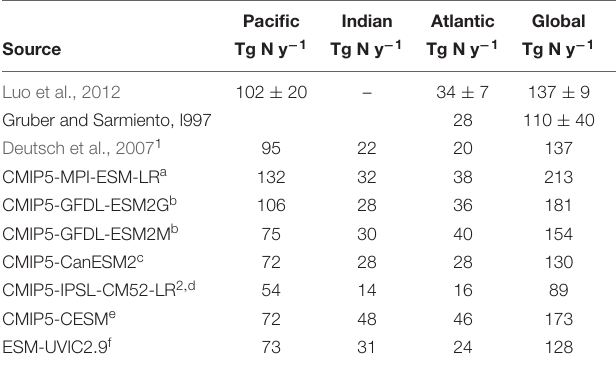
TABLE 1 | Experimental, geochemical, and ESM-based (1996–2005 average) regional and global annual N 2 fixation estimates (Tg N y − 1